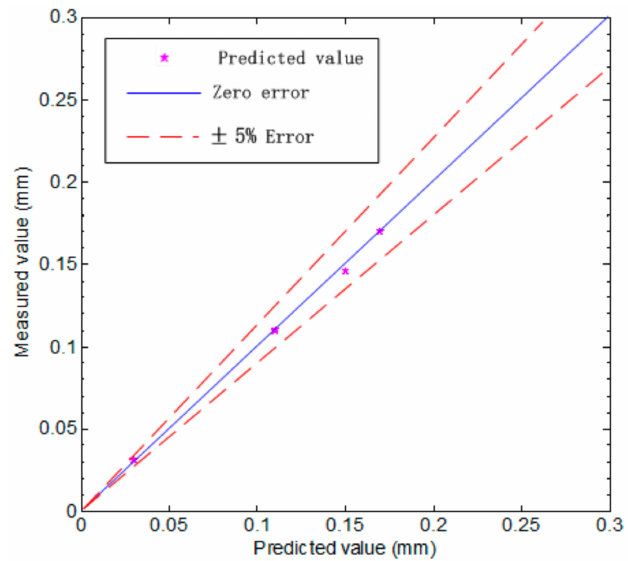
Figure 12. Boxplot comparison of 10 groups of the predicted values.